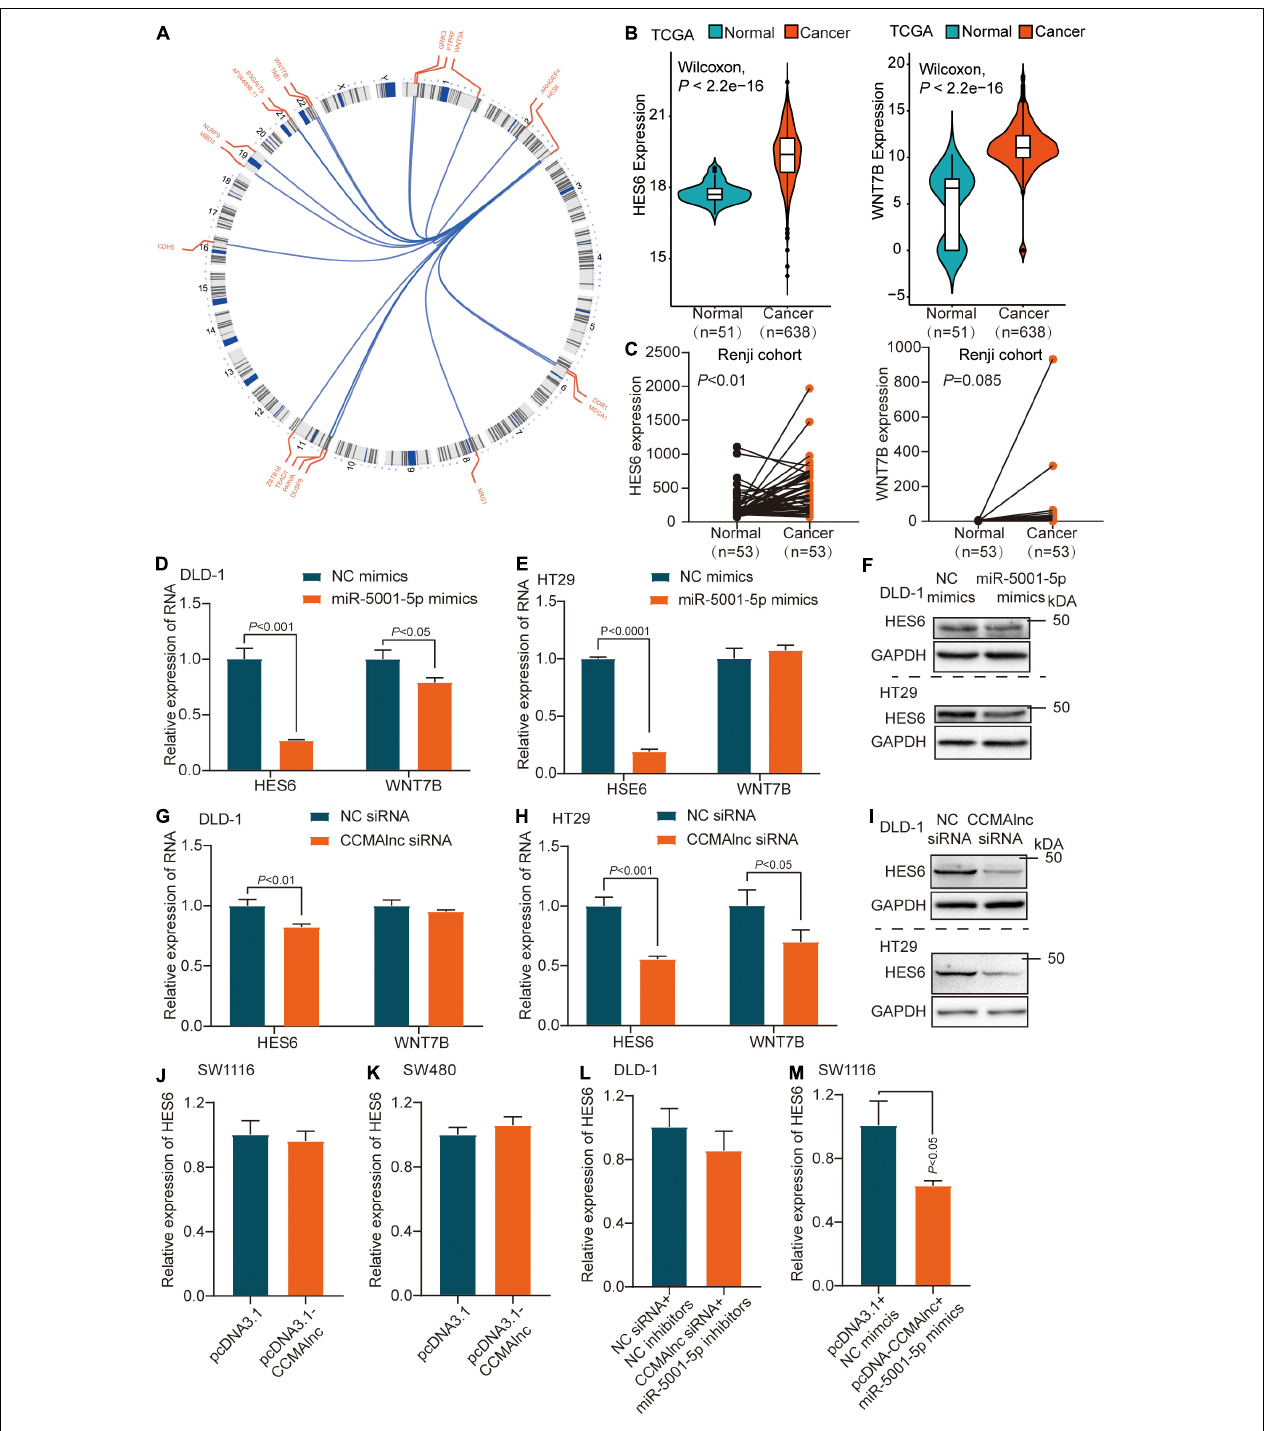
FIGURE 4 | HES6 is a target of miR-5001-5p controlled by CCMAlnc. (A) Circos plot of predicted target genes of miR-5001-5p reported to participate in the growth and metastasis of CRC. (B,C) The expression of HES6 and WNT7B in normal and CRC tissues in the TCGA database (B) and Renji cohort (C) . (D,E) The expression of HES6 and WNT7B after transfection with miR-5001-5p mimics and control mimics in DLD-1 and HT29 cells at RNA level. (F) The expression of HES6 after transfection with miR-5001-5p mimics and control mimics in DLD-1 and HT29 cells at protein level. (G,H) The expression of HES6 and WNT7B after transfection with CCMAlnc siRNA and control siRNA in DLD-1 and HT29 cells at RNA level. (I) The expression of HES6 after transfection with CCMAlnc siRNA and control siRNA in DLD-1 and HT29 cells at protein level. (J,K) The expression of HES6 in SW1116 and SW480 cells transfected with CCMAlnc overexpression vector and control vector. (L) The effect of control siRNA or CCMAlnc siRNA combined with miR-5001-5p inhibitiors on the RNA level of HES6. (M) The effect of control vector or CCMAlnc overexpression vector combined with miR-5001-5p overexpression vector on the RNA level of HES6.